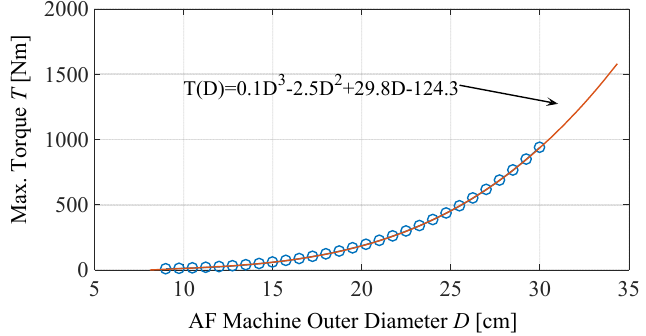
Figure 1. Maximum double air gap yokeless Axial Flux (AF) machine torque T as function of outer diameter D = D out with constant inner to outer diameter ratio of 0.6.